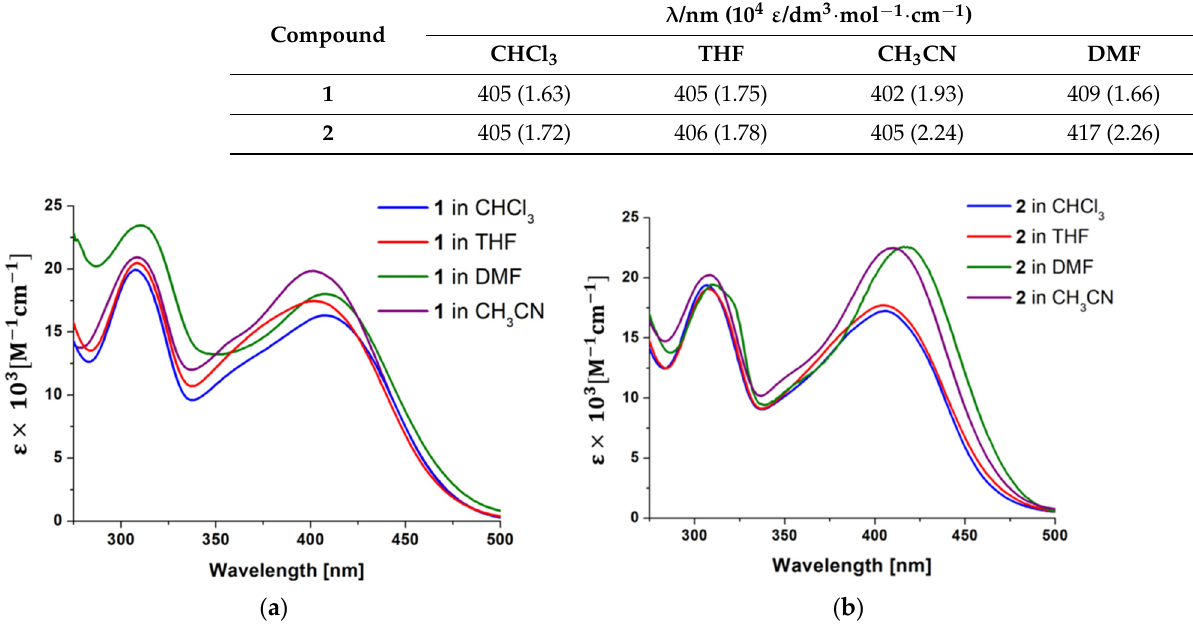
Figure 2. UV-Vis spectra of 1 (a) and 2 (b) in solvents of different polarity. Table 1. The absorption maxima and molar extinction coefficient for 1 and 2 in solvents of different